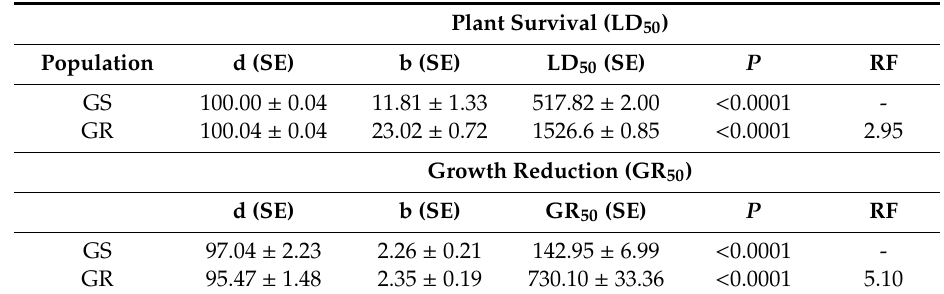
± is the standard errors of 50 , LD 50 ); SE